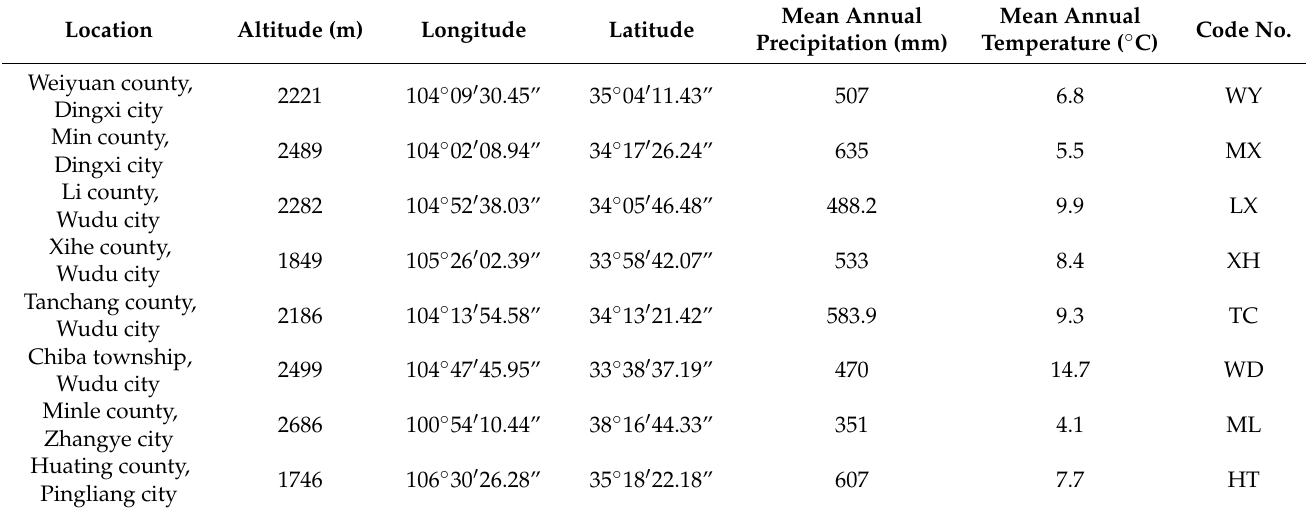
Table 1. The information of material and sample area.